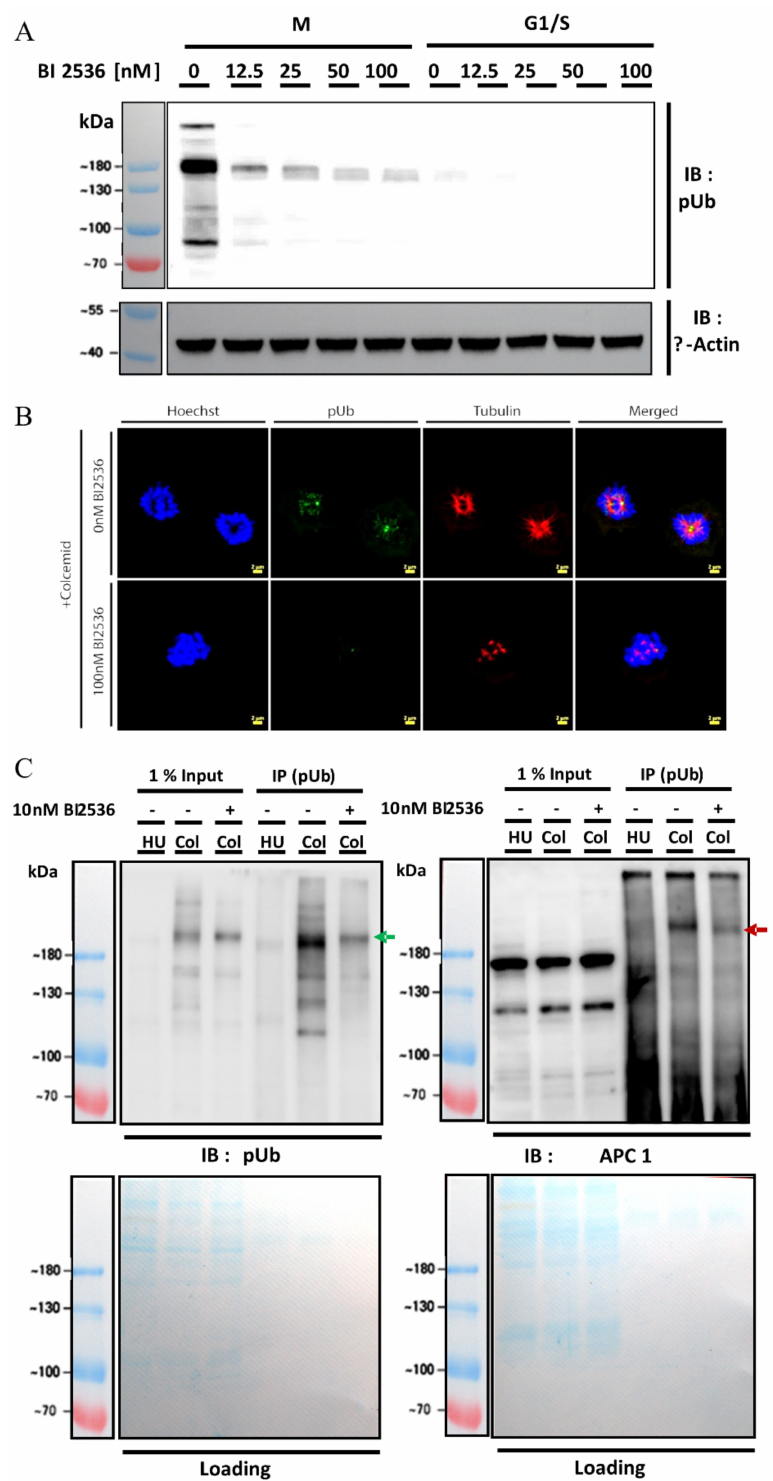
Figure 4. Mitotic pUb signal is PLK1 dependent and correlates with APC1. ( A ) Western blot analysis of mitotic cells treated with and without PLK1 inhibition; ( B ) confocal image of mitotic cells with and without PLK1 inhibition; ( C ) APC1 is enriched in mitotic cells by pUb antibody and PLK1 inhibition reduces the APC1 enrichment by pUb antibody from parallel electroporation and Western blot analysis of same samples using different antibodies. Arrows mark the similarly migrating band detected by both antibodies. Representative result of two independent experiments. Loading control is InstaBlue TM